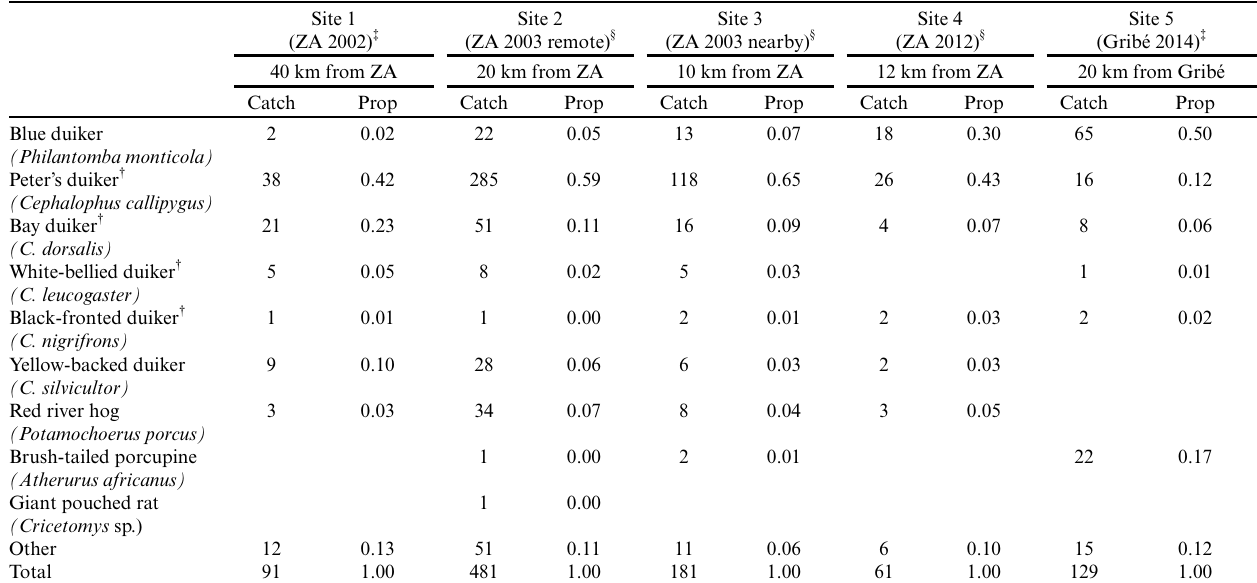
† Medium-sized duikers. ‡ Data were obtained via direct observation at the camps. § Data were obtained via interviews with hunters on the snare lines around two months after the snares were set. Prop indicates proportion; ZA, Zoulabot